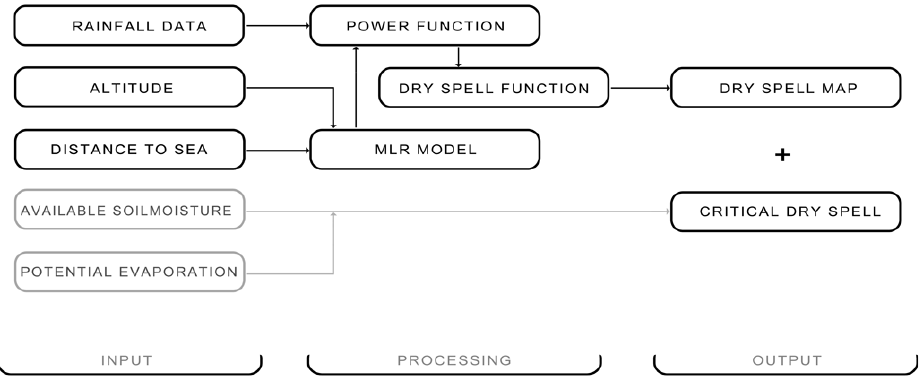
Fig. 2. Flow chart of the Markov-based framework for critical dry spell analysis. From left to right are the input variables which are processed to generate the output of dry spell length maps for fixed probabilities of non-exceedance. Combining this together with critical dry spell information, based on available soil moisture and evaporation, serves to assess the probability of crop